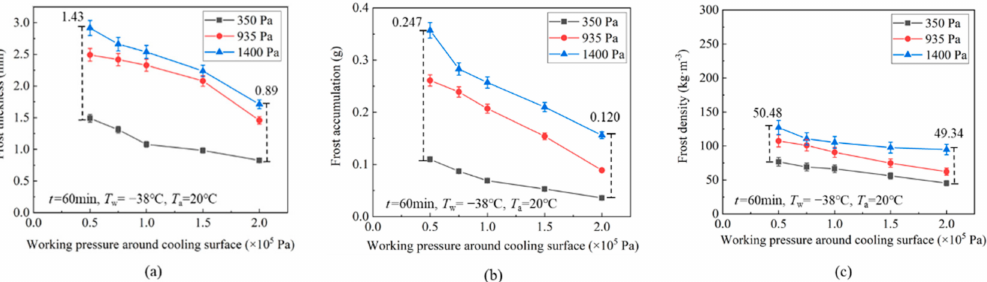
Figure 9. ( a ) Frost thickness; ( b ) frost accumulation; ( c ) frost density with working pressure around cooling surface under different partial pressures of water vapor at 60 min.